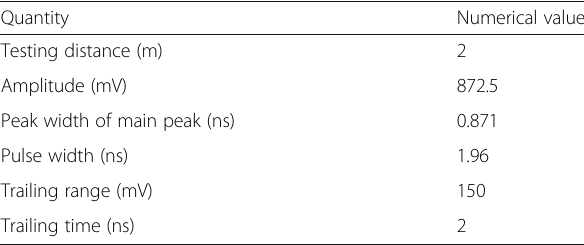
Table 1 Main parameters for the electromagnetic pulses